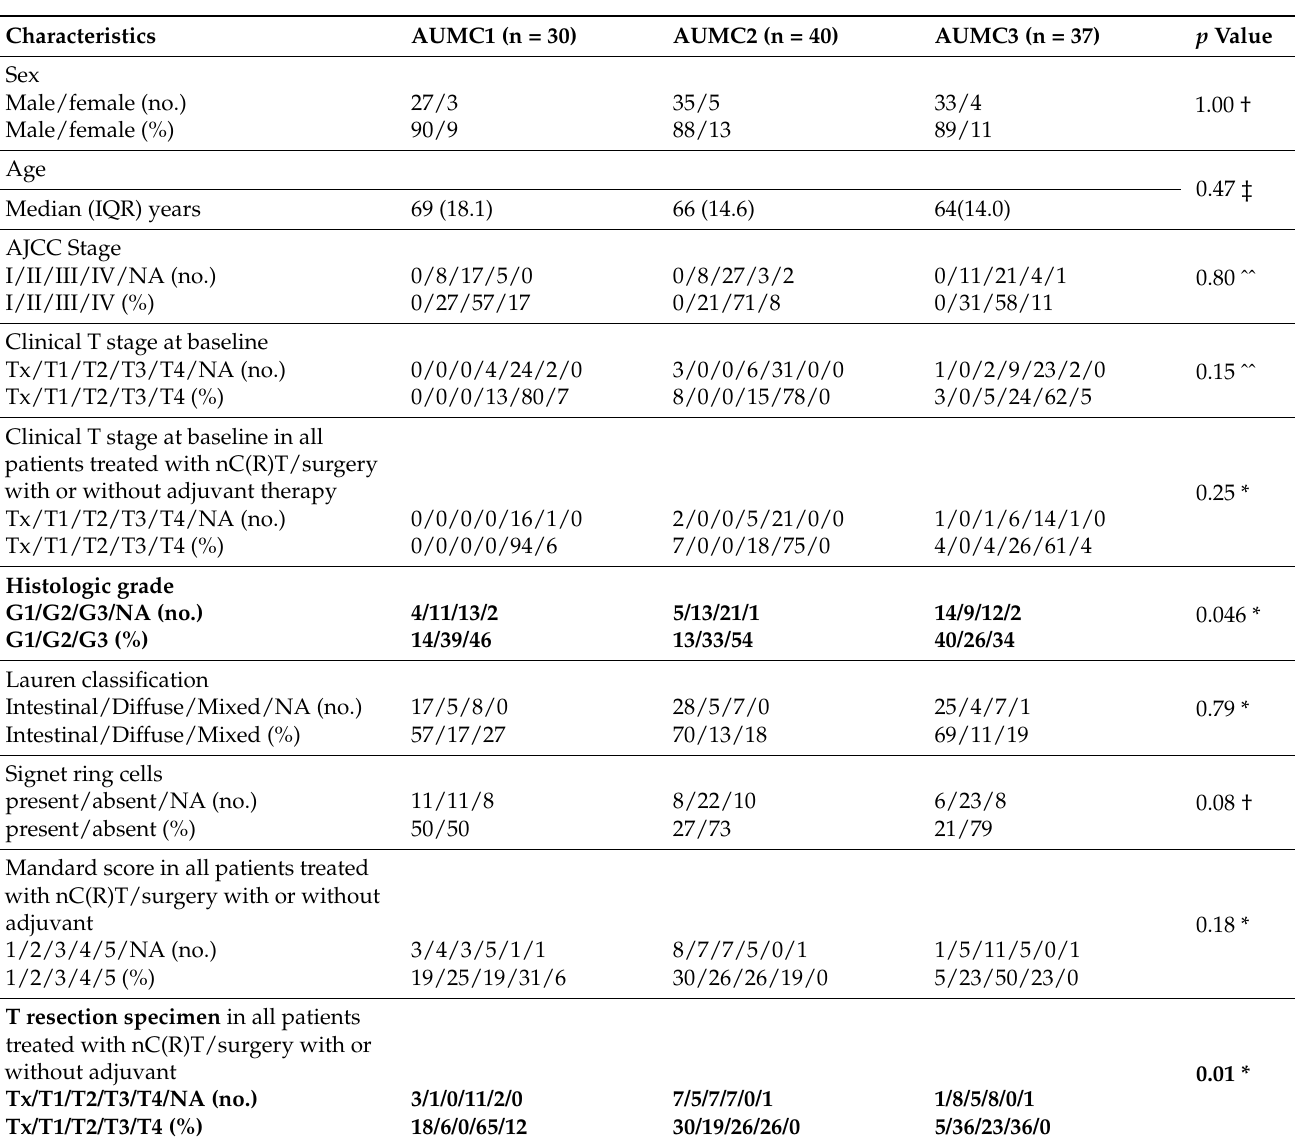
Table 2. Differences between subgroups in AUMC